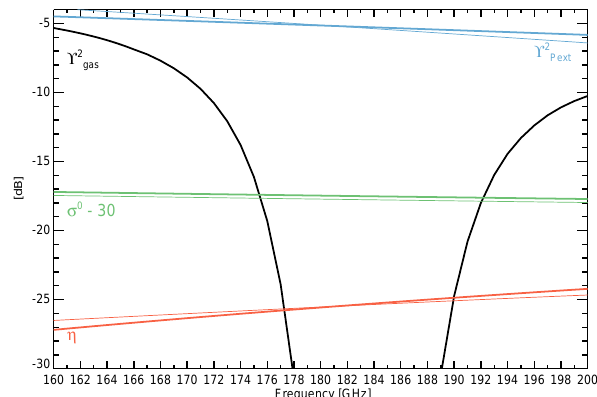
Figure 1. Example of a typical atmospheric transmittance due to (ν) , blue), as well gases ( ϒ 2 gas (ν) , black) and hydrometeors ( ϒ 2 Pext as the backscatter reflectivity ( η(ν) , red), and the ocean backscatter (ν) green, offset by 30dB) for a surface return journey (down- ( σ 2 0 ward atmospheric pass, surface reflection, upward pass) for a nim- bostratus cloud near the 183GHz H 2 O band region. The atmo- spheric profile was taken from CloudSat data as described in Sect. 3. The ocean backscatter corresponds to a surface wind of 3ms − 1 and temperature of 28 ◦ C. Note that only the transmittance due to gases shows a significant frequency dependence. Thin lines show the im- pact of assuming a different particle size distribution or a differ- ent surface wind. These lines have been offset to ease comparison against the unperturbed